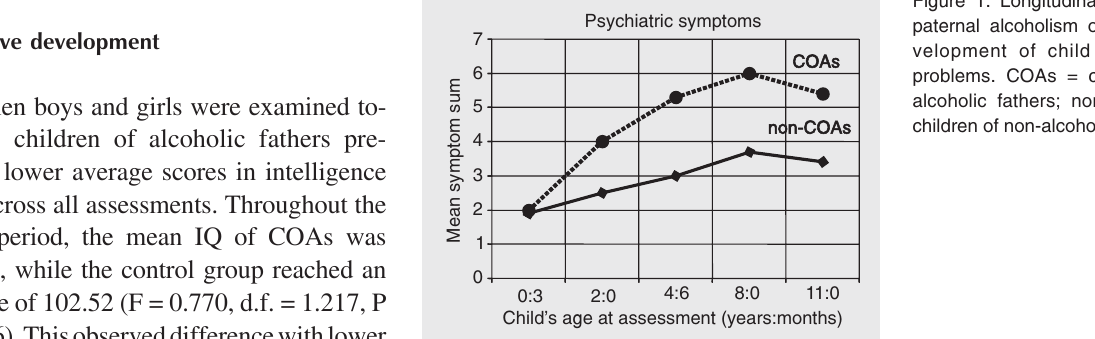
Figure 1. Longitudinal effect of paternal alcoholism on the de- velopment of child behavior problems. COAs = children of alcoholic fathers; non-COAs = children of non-alcoholic